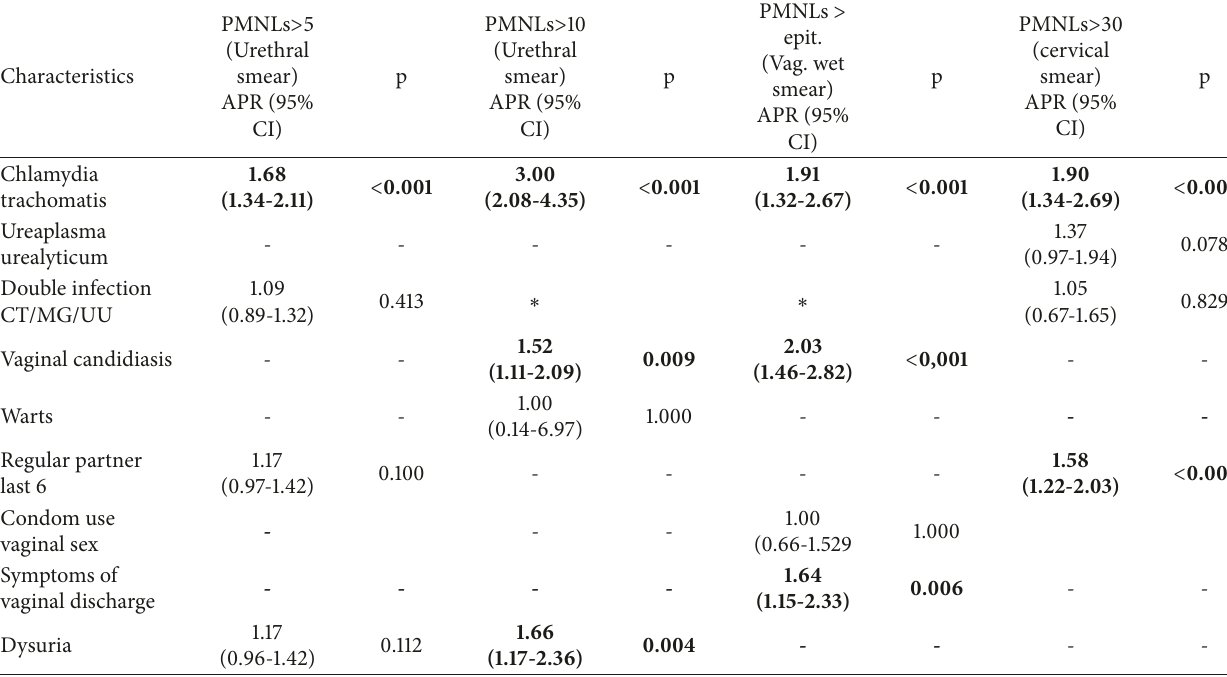
Table 2: Adjusted prevalence ratios of microscopic signs of inflammation in urethra, vagina, and cervix cervicitis by significant pathogens, conditions, and behavioral characteristics in the univariate